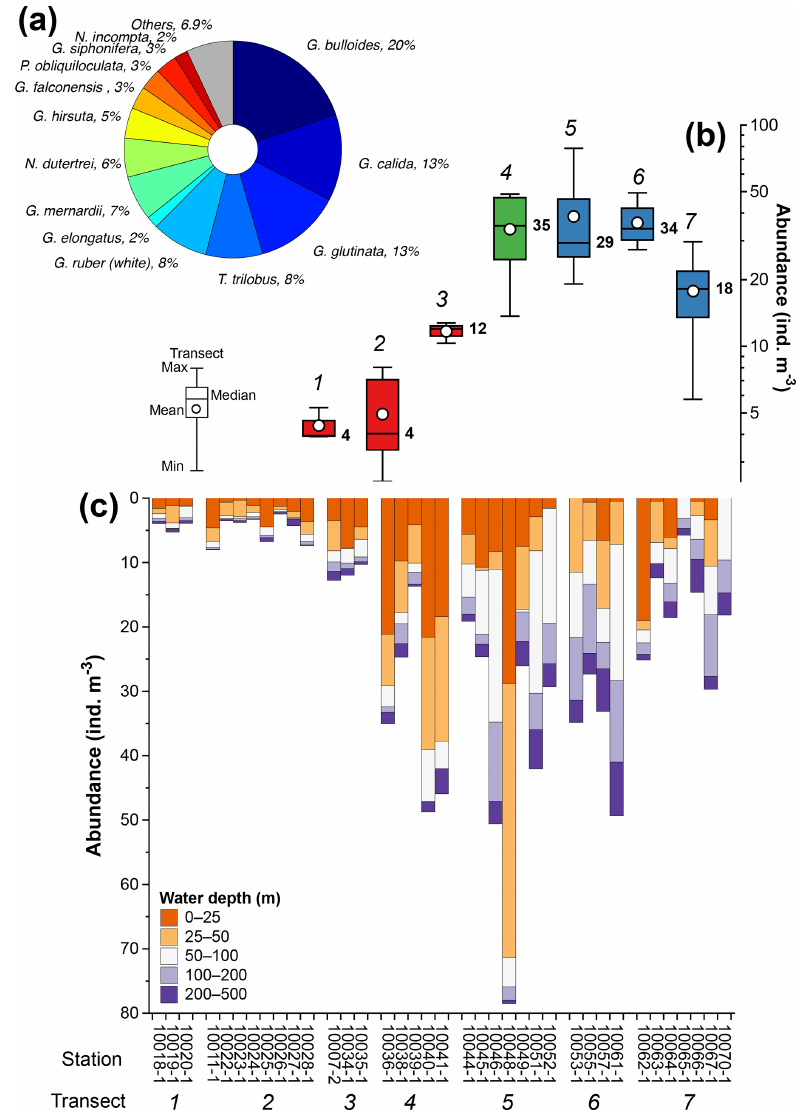
Figure 4. Summary of planktic foraminifera census counts off Indonesia. (a) Species with > 2% contribution to the total assemblage, (b) abundance distribution of planktic foraminifera in transects 1 to 7, and (c) abundance of planktic foraminifera by water depth interval at each station. Numbers in (b) represent transects 1 to 7 (italic) and median values of transects (bold); colors in (b) depict sectors off Sumatra (red), transitional sectors (green), and off Java–LSI (blue). The five sampled water depths are 0–25m (tangerine), 25–50m (orange), 50– 100m (white), 100–200m (lilac), and 200–500m (purple). Stations are grouped by transect (number). Schematic of the box plots showing the median value (horizontal line); the whisker marks the minimum (min) and maximum (max) values. White dots denote the mean of data distribution. Note the difference between the mean and median, where the former is more susceptible to extreme low and high values. Please note the different scales for the y axis in (b) (log scale) and (c) (linear